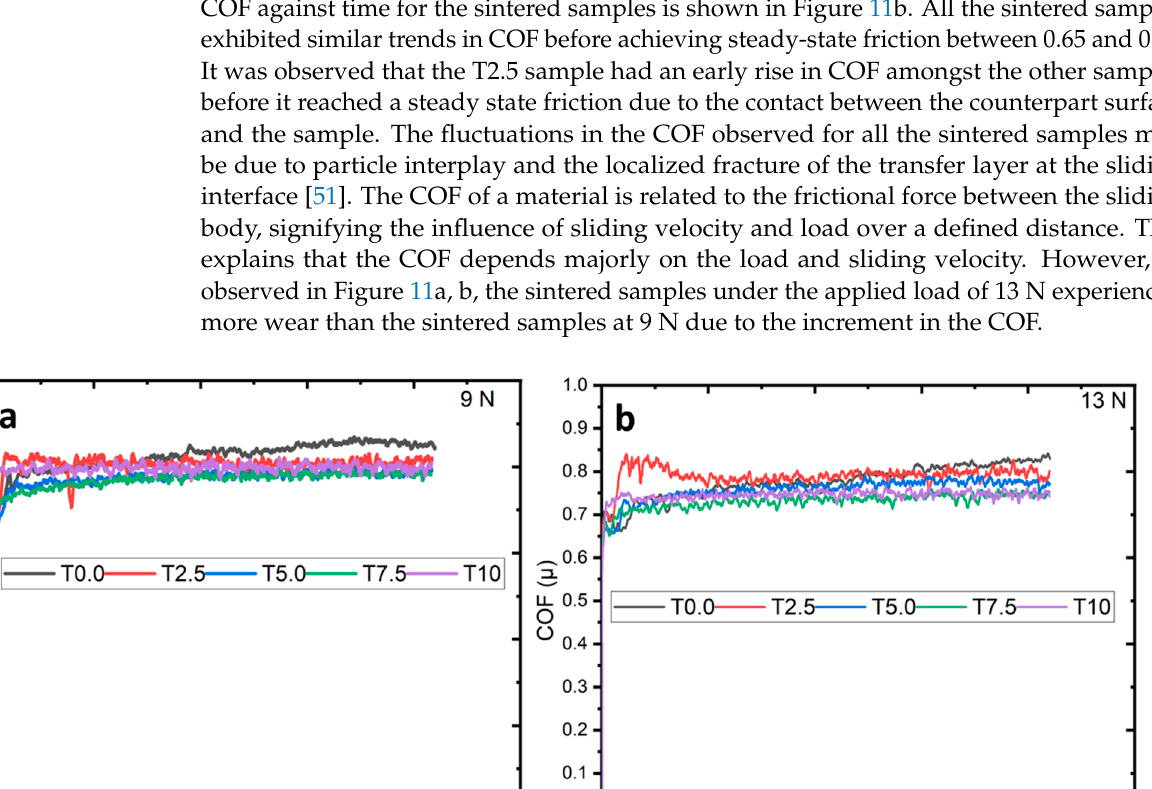
Figure 12. The plot of the mean COF for the sintered samples under 9 N and 13 N loads.